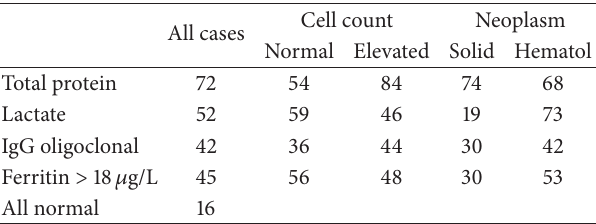
Table 2: Percentage of pathological values of standard CSF proteins in cases of neoplastic meningitis.